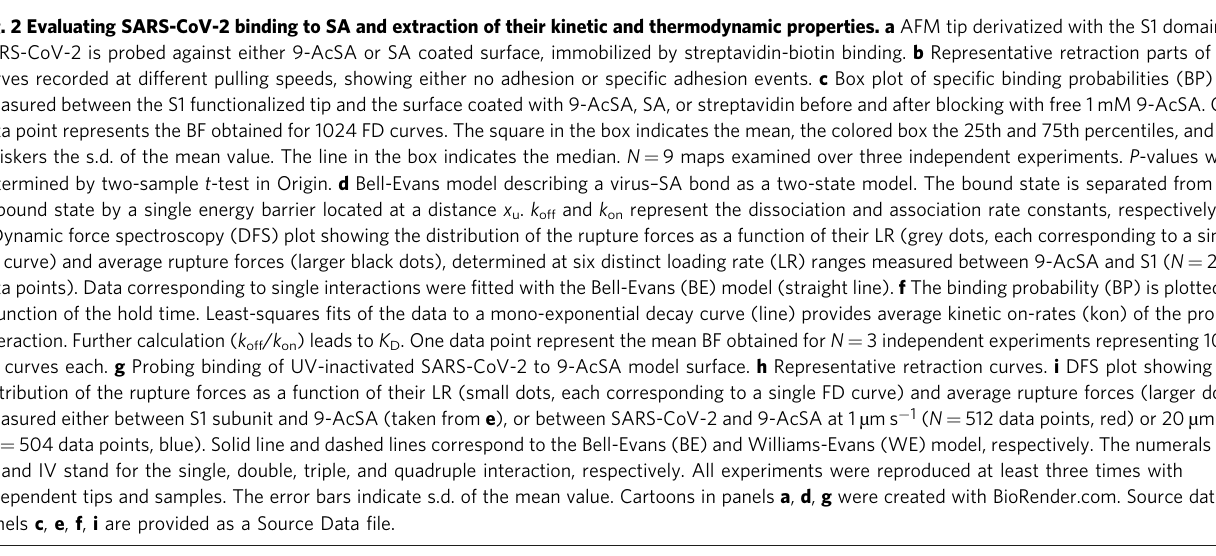
Fig. 2 Evaluating SARS-CoV-2 binding to SA and extraction of their kinetic and thermodynamic properties. a AFM tip derivatized with the S1 domain of SARS-CoV-2 is probed against either 9-AcSA or SA coated surface, immobilized by streptavidin-biotin binding. b Representative retraction parts of FD curves recorded at different pulling speeds, showing either no adhesion or speci fi c adhesion events. c Box plot of speci fi c binding probabilities (BP) measured between the S1 functionalized tip and the surface coated with 9-AcSA, SA, or streptavidin before and after blocking with free 1 mM 9-AcSA. One data point represents the BF obtained for 1024 FD curves. The square in the box indicates the mean, the colored box the 25th and 75th percentiles, and the whiskers the s.d. of the mean value. The line in the box indicates the median. N = 9 maps examined over three independent experiments. P -values were determined by two-sample t -test in Origin. d Bell-Evans model describing a virus – SA bond as a two-state model. The bound state is separated from the unbound state by a single energy barrier located at a distance x u . k off and k on represent the dissociation and association rate constants, respectively. e Dynamic force spectroscopy (DFS) plot showing the distribution of the rupture forces as a function of their LR (grey dots, each corresponding to a single FD curve) and average rupture forces (larger black dots), determined at six distinct loading rate (LR) ranges measured between 9-AcSA and S1 ( N = 2331 data points). Data corresponding to single interactions were fi tted with the Bell-Evans (BE) model (straight line). f The binding probability (BP) is plotted as a function of the hold time. Least-squares fi ts of the data to a mono-exponential decay curve (line) provides average kinetic on-rates (kon) of the probed interaction. Further calculation ( k off / k on ) leads to K D . One data point represent the mean BF obtained for N = 3 independent experiments representing 1024 distribution of the rupture forces as a function of their LR (small dots, each corresponding to a single FD curve) and average rupture forces (larger dots) measured either between S1 subunit and 9-AcSA (taken from e ), or between SARS-CoV-2 and 9-AcSA at 1 µ m s − 1 ( N = 512 data points, red) or 20 µ m s − 1 ( N = 504 data points, blue). Solid line and dashed lines correspond to the Bell-Evans (BE) and Williams-Evans (WE) model, respectively. The numerals I, II, III, and IV stand for the single, double, triple, and quadruple interaction, respectively. All experiments were reproduced at least three times with independent tips and samples. The error bars indicate s.d. of the mean value. Cartoons in panels a , d , g were created with BioRender.com. Source data in panels c , e , f , i are provided as a Source Data